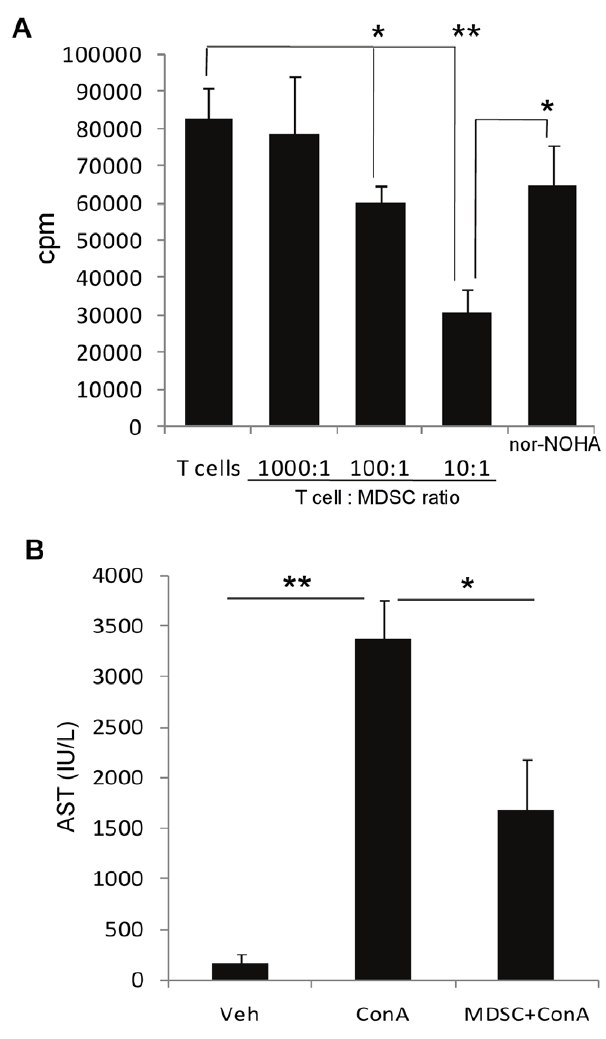
Figure 5. CBD-induced MDSCs in liver are immunosuppressive invitro and invivo. CD11b + Gr-1 + cells from liver infiltrating cells of ConA + CBD injected mice were purified, irradiated and co-cultured at different ratios with naı¨ve syngenic purified T cells in the presence of mitogen ConA (4 m g/mL) for 48 h. T cell proliferation was determined by [3H]thymidine incorporation during the last 8 h of culture. In some wells with T cell: MDSC ratio of 10:1, arginase-1 inhibitor (nor-NOHA) was added at the start of the culture at a concentration of 100 m M. Data are mean 6 SEM of triplicate determinations and representative of two independent experiments. (B) WT mice (n=4) were injected with vehicle or ConA. Five million purified CD11b + Gr-1 + cells isolated from livers of ConA + CBD group, were adoptively transferred 12 h before injecting ConA. Blood was collected 12 h post-ConA injection and analyzed for AST. Data represent mean 6 SEM from 4 mice per treatment. Student’s t- test (*p , 0.05, **p , 0.01).